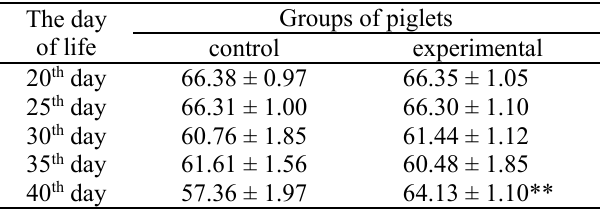
The level of globulins in the serum of piglets by the action of the feed additive “Butaselmevit-plus”, % (M ± m, n = 5) The day